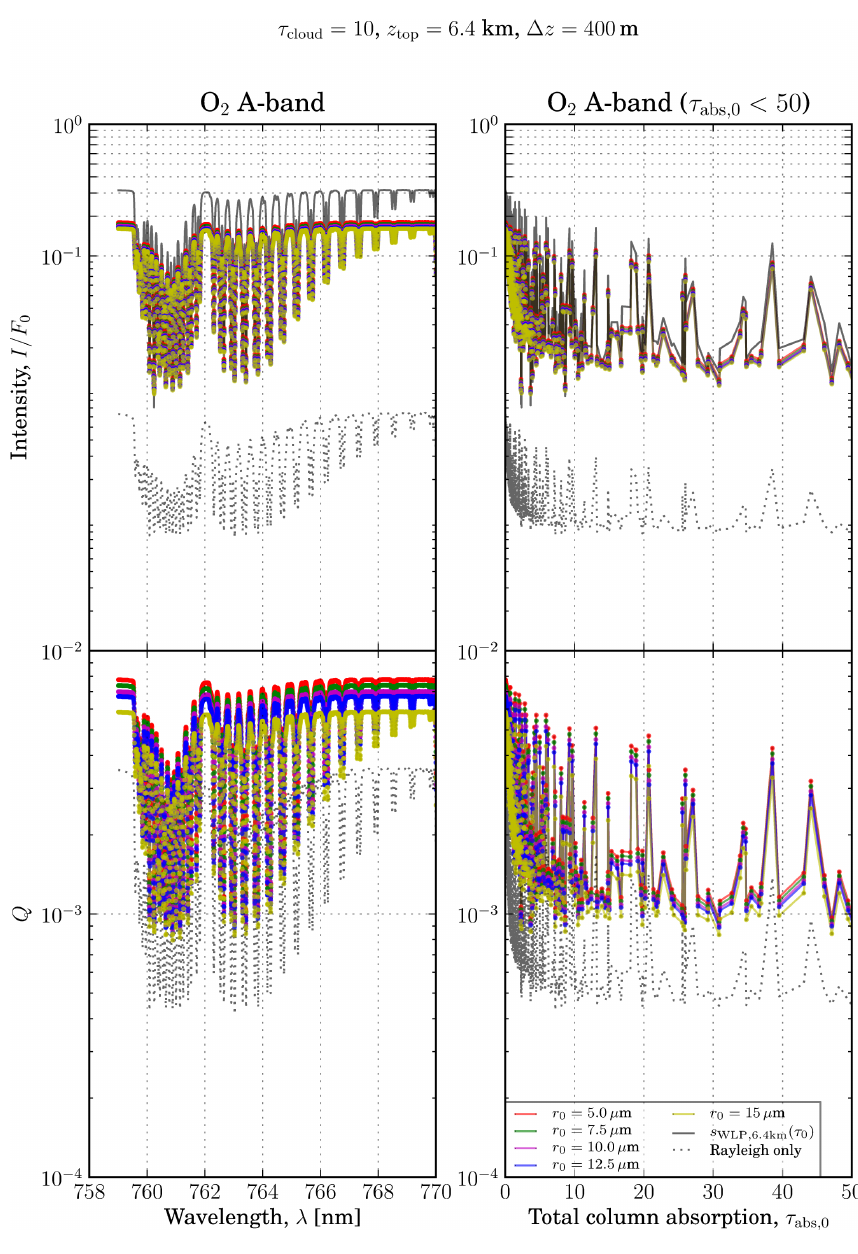
Figure 7. Intensity (top) and degree of polarization (bottom) due to a cloud-laden atmosphere of constant cloud optical depth, τ cloud = 10 at a top height of z top = 6 . 4km but varying median cloud droplet radii in the O 2 A